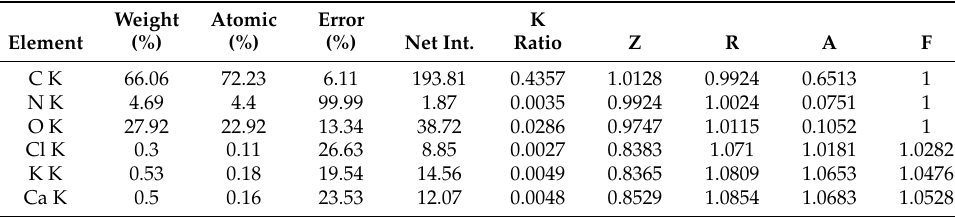
Figure 4. Distribution spectrum of the chemical elements in specimen D5 by EDS analysis, obtained at a 2.110 keV intensity. Table 2. Individual values of the chemical composition for the analyzed areas.